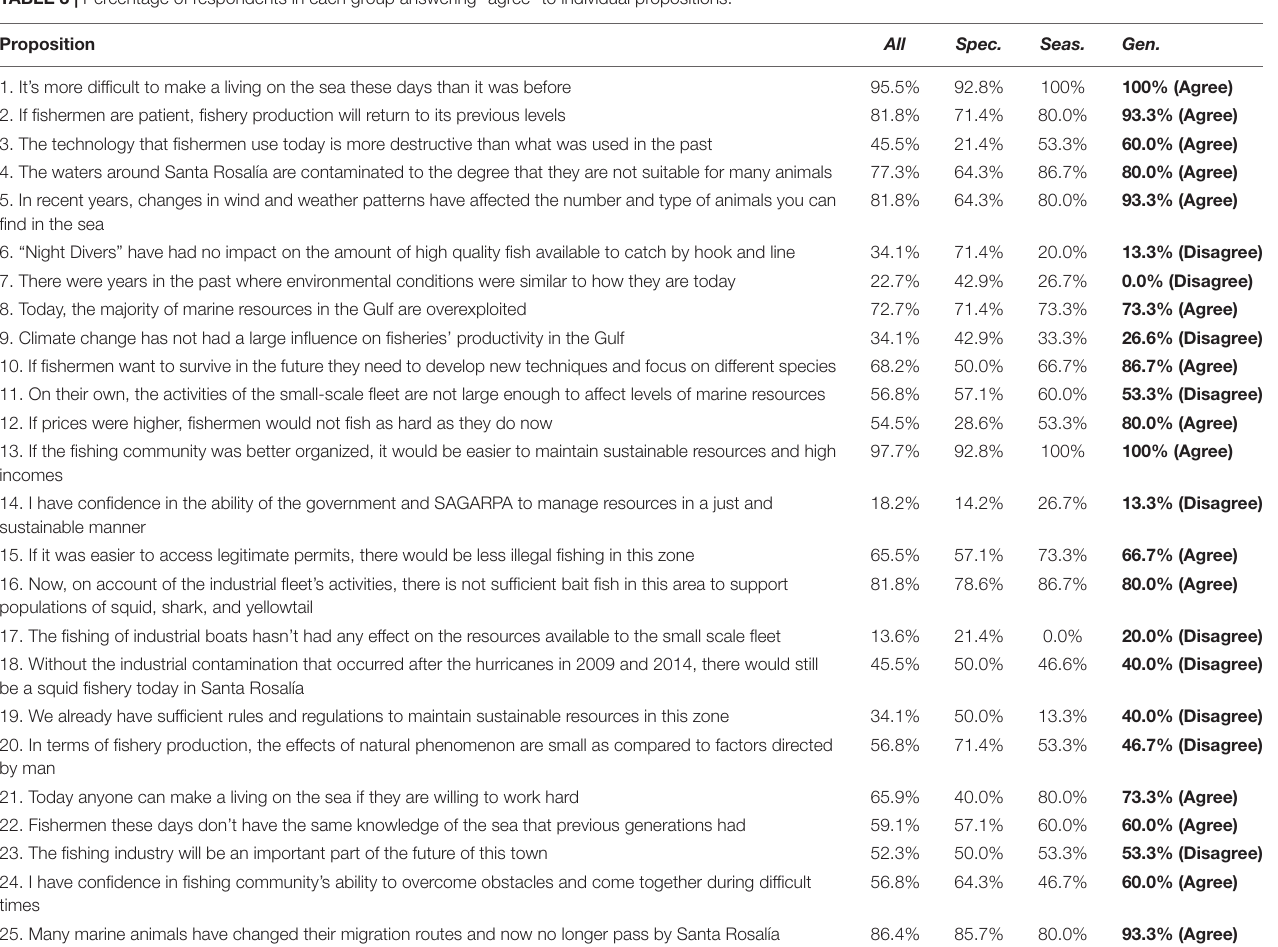
TABLE 3 | Percentage of respondents in each group answering “agree” to individual